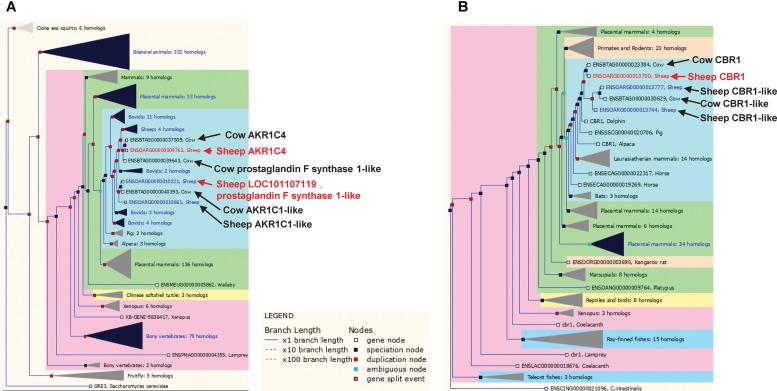
Trees for the aldo-keto reductase and short chain dehydrogenase/reductase gene families. (A) Aldo-keto reductase gene family, including sheep genes ENSOARG00000009762 and ENSOARG00000010221 (red text). (B) Short chain dehydrogenase/reductase gene family including the sheep gene ENSOARG00000013700 (red text). Other ruminant genes closely related to ENSOARG00000009762, ENSOARG00000010221, and ENSOARG00000013700 were also labeled in dark text.